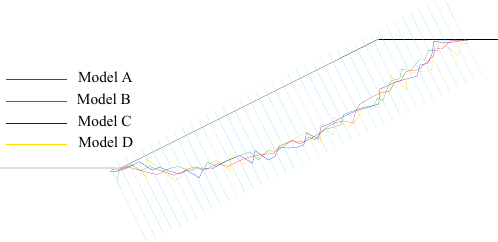
Figure 8. The distribution of maximum equivalent plastic strain for Example 1.